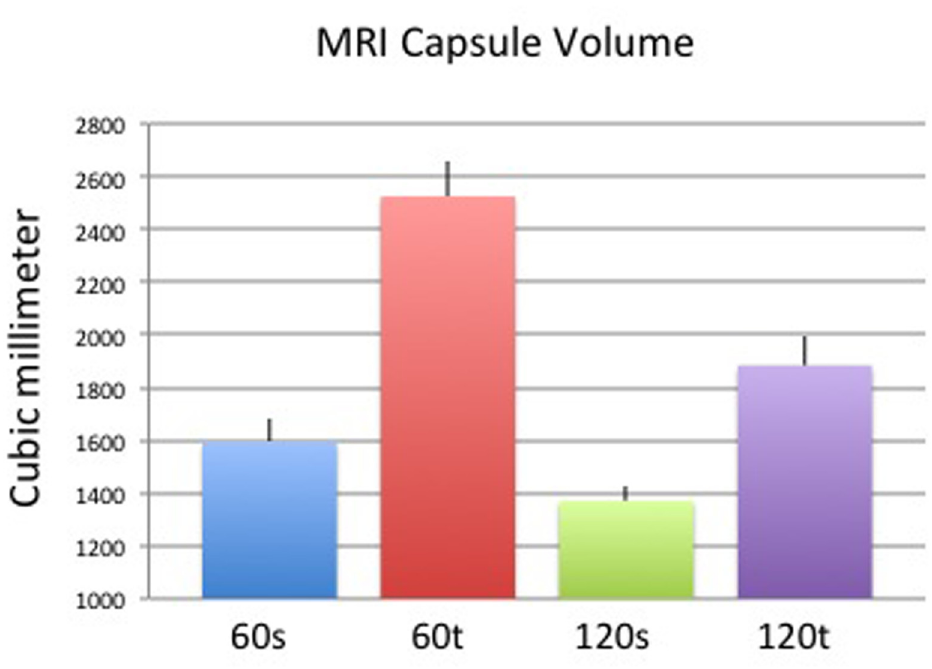
Fig 9. Mean (+/- standard deviation) capsule volume in MRI of each study group. Results were not statistically significant.